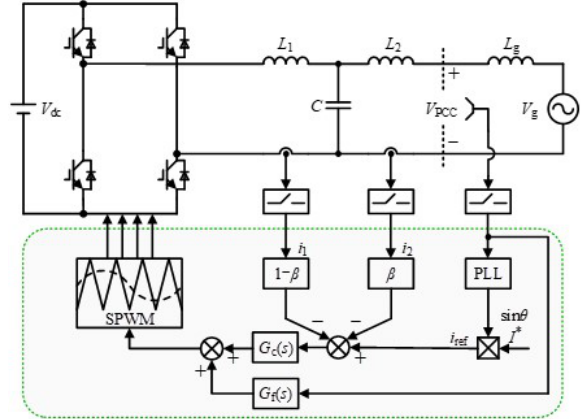
Fig. 1. The overall block diagram of the grid-connected inverter using WAC control system